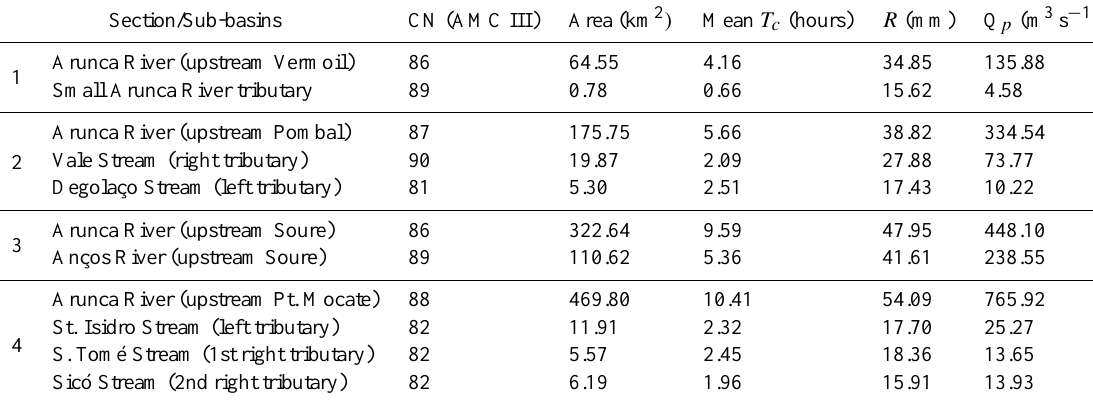
Table 3. Parameters and results regarding peak flow